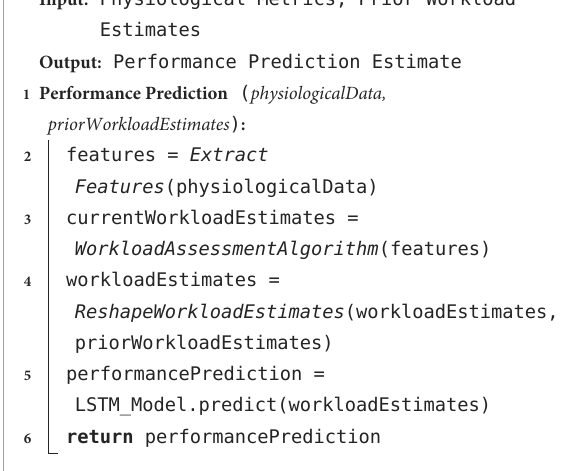
Algorithm 1. Performance prediction